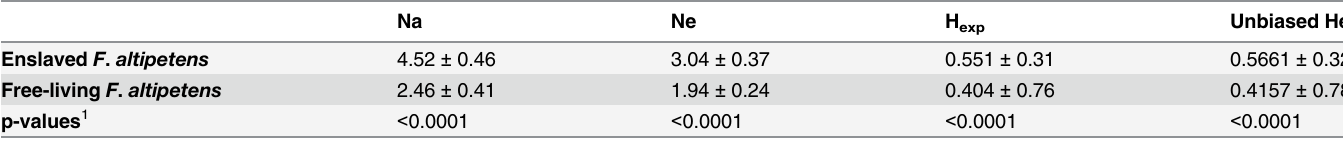
Table 3. Comparison of average ( ± SD) genetic composition found within colonies of enslaved (N = 10 colonies; 189 individuals total) and free-liv- ing F . altipetens (N = 10 colonies; 182 individuals total). Na = number of alleles, Ne = effective number of alleles, and H exp = expected heterozygosity and all other statistics listed are averaged over the 11 microsatellite loci used in this